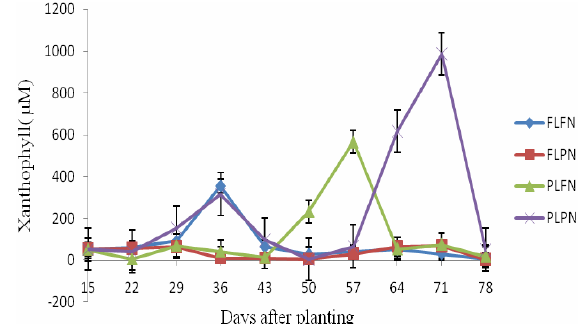
Fig. 4. Effect of light and nutrient stress on the dry weight of plants